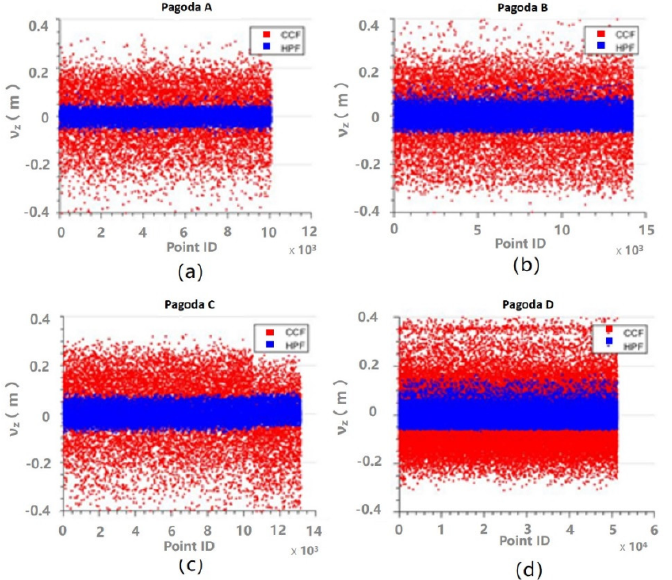
Figure 10. Residuals of z for the CCF (red) and the HPF (blue) for Part 2: ( a ) Pagoda A; ( b ) Pagoda B; ( c ) Pagoda C; and ( d ) Pagoda